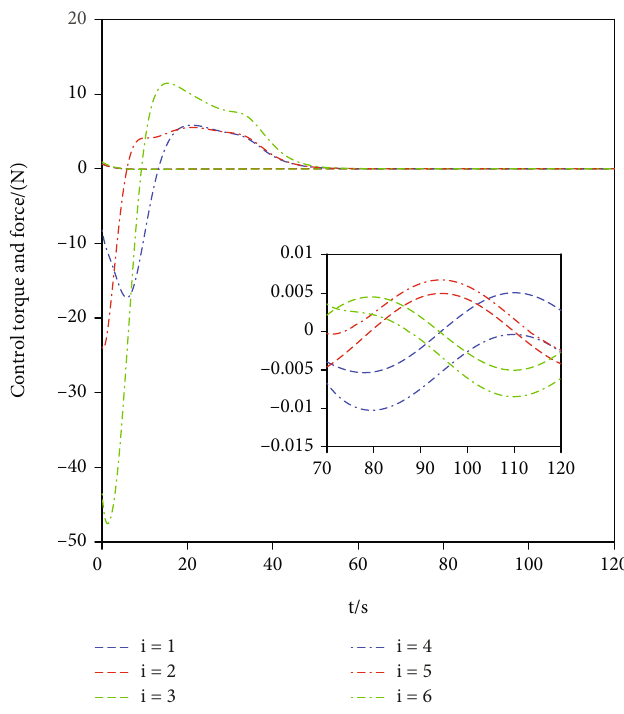
Figure 6: Control torque and force curves.